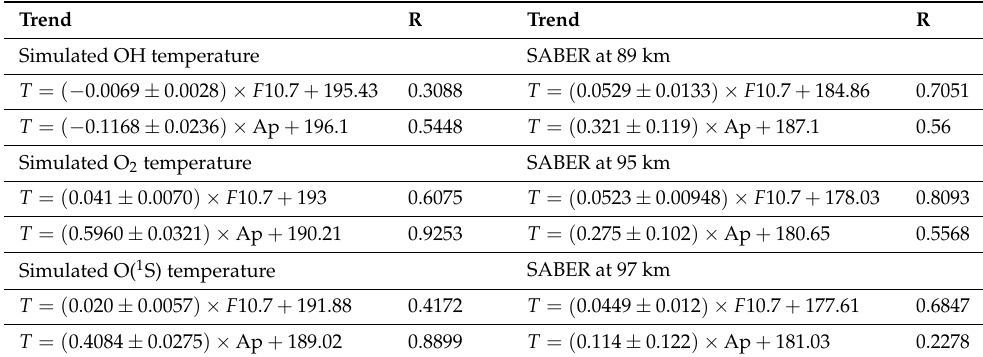
Figure 4. Zonal mean annual average of SABER temperature at 18° N at 89 km. ( a ) Time series of temperature (blue line with dots), F10.7 (red line), and Ap index (brown dashed line). ( b ) Trend analysis of temperature as a function of the F10.7 (red line and dots) and of the Ap index (brown dashed line and triangles). Table 1. F10.7 and Ap index trends with correlation coefficient R obtained from the simulated airglow temperatures and annual mean SABER temperature measurements at 18 ◦ N, 290 ◦